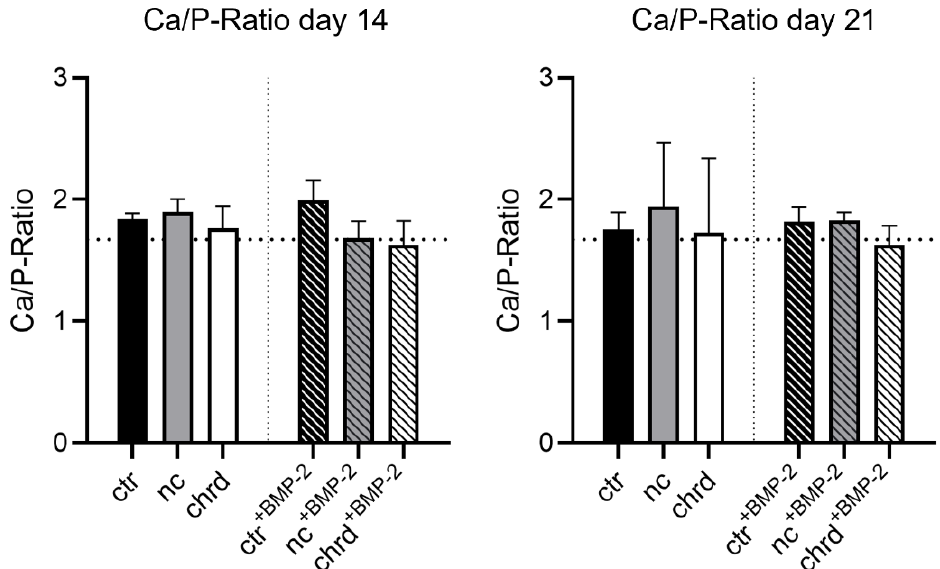
Figure 6. Close-up of cGM in the early and late mineralization phase stained with Alizarin Red staining (ARS) or OsteoImage (HA). The mineralized areas have been marked with dashed lines in green for the inner mineralization zone, in blue for the outer mineralization zone, and orange for completely mineralized particles.